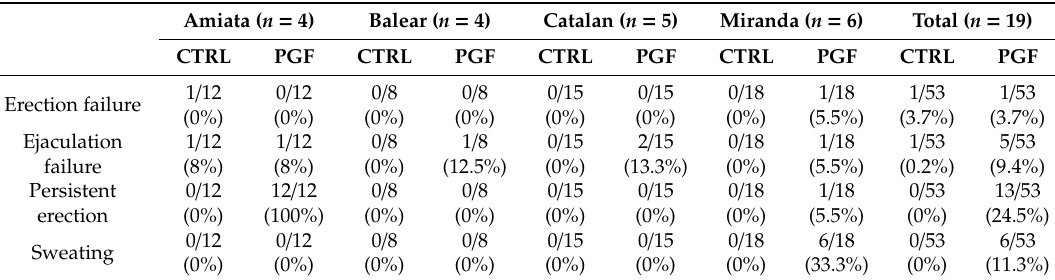
Table 1. Erection failure, ejaculation failure, persistent erection, and sweating in jacks treated with 125 µ g of cloprostenol sodium (PGF) or 1 mL of saline (CTRL) prior to semen collection mount in an estrus jenny. Three semen collections were performed in each of the assigned groups (PGF vs. Control)